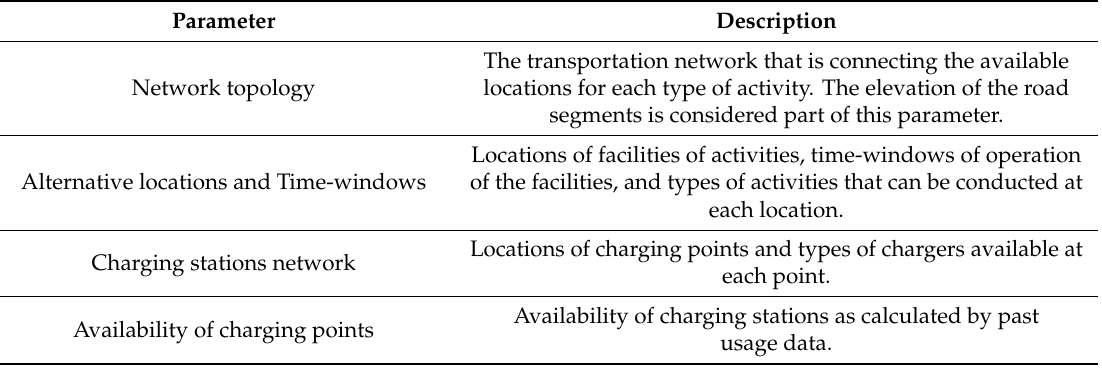
Table 3. The third group of parameters that are independent of the user’s